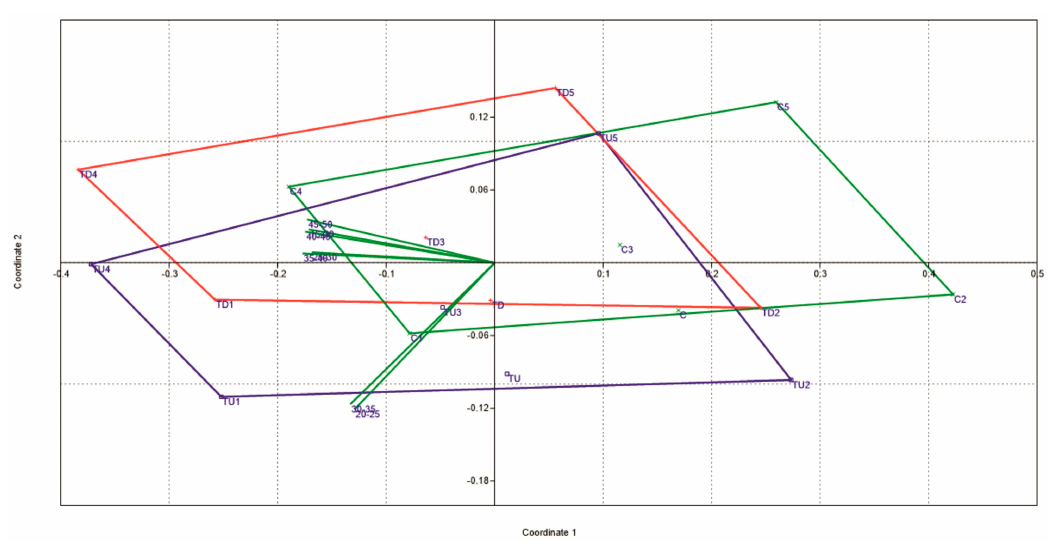
Figure 2. Polynomial regression of weighted yearly ring width (YWW) (i.e., the mean of yearly ring width weighted on the basis of the frequency distribution of trees per each diameter class in 2017) from ‘70s to 2017. The non-linear regression analysis results are shown in Table 8.